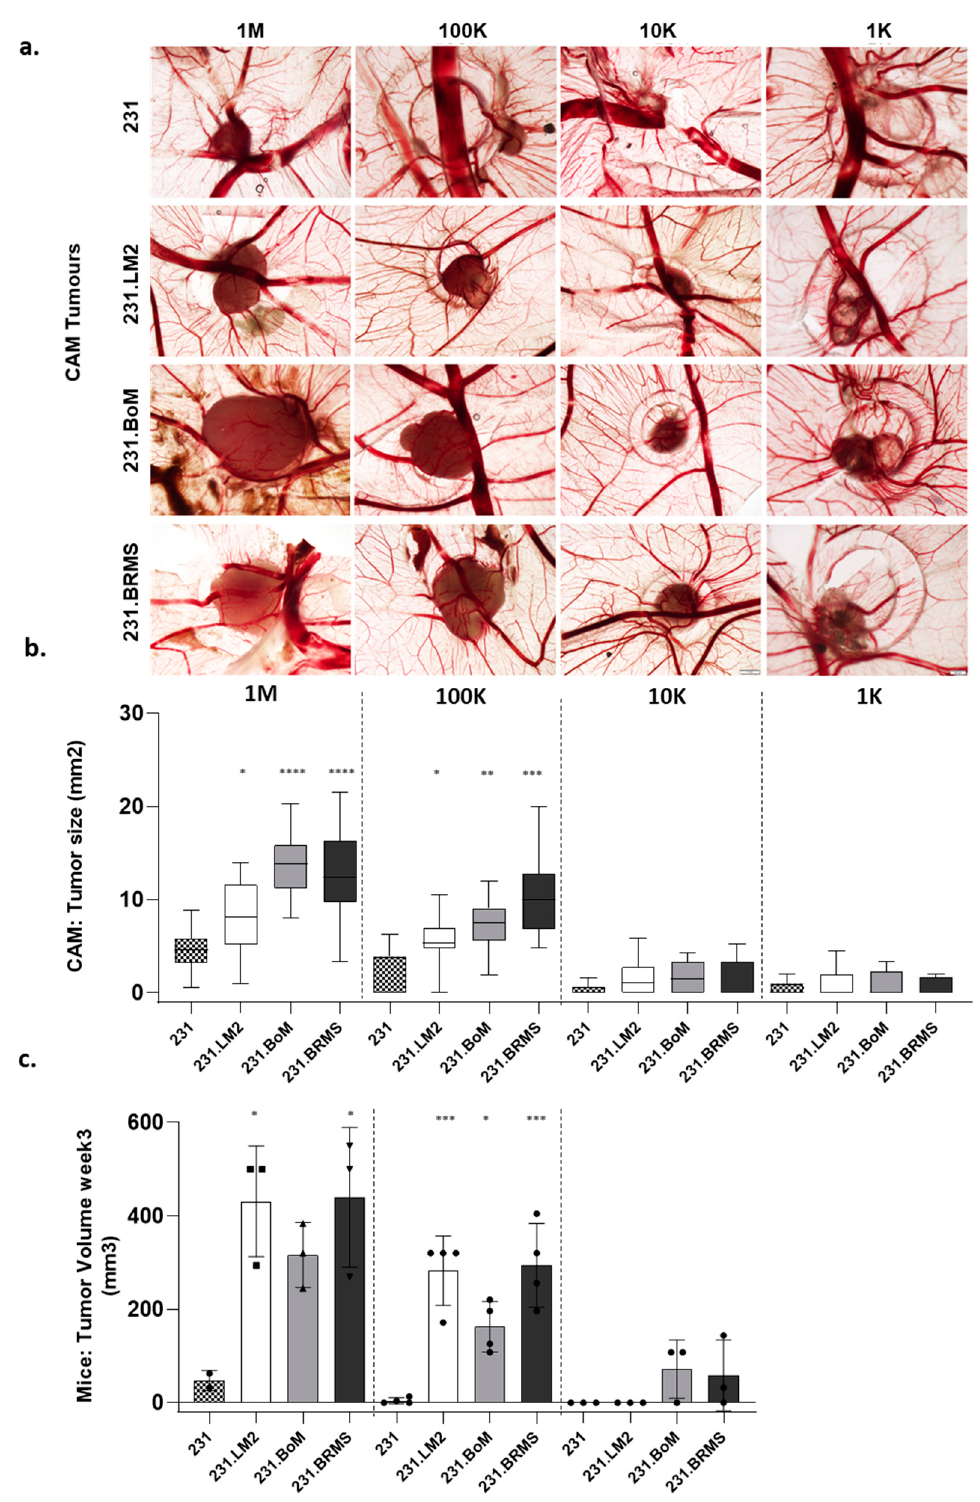
Figure 4. Organotropic breast cancer cells display an increased tumorigenic ability in the choriallantoic membrane of the chick embryo (CAM). ( a ) Representative pictures of CAM xenografted tumors (4 cell lines × 4 cell dilutions); scale bar = 500 µ m. ( b ) Tumor size evaluation in the LDA performed in the CAM by inoculations of 1-M, 100-K, 10-K and 1-K cells per egg. ( c ) Tumor size evaluation in a LDA performed in immunodeficient mice by subcutaneous injection of 1-M, 100-K and 10-K cells number per animal. *— p < 0.05, **— p < 0.01, ***— p < 0.001 and ****— p < 0.0001).